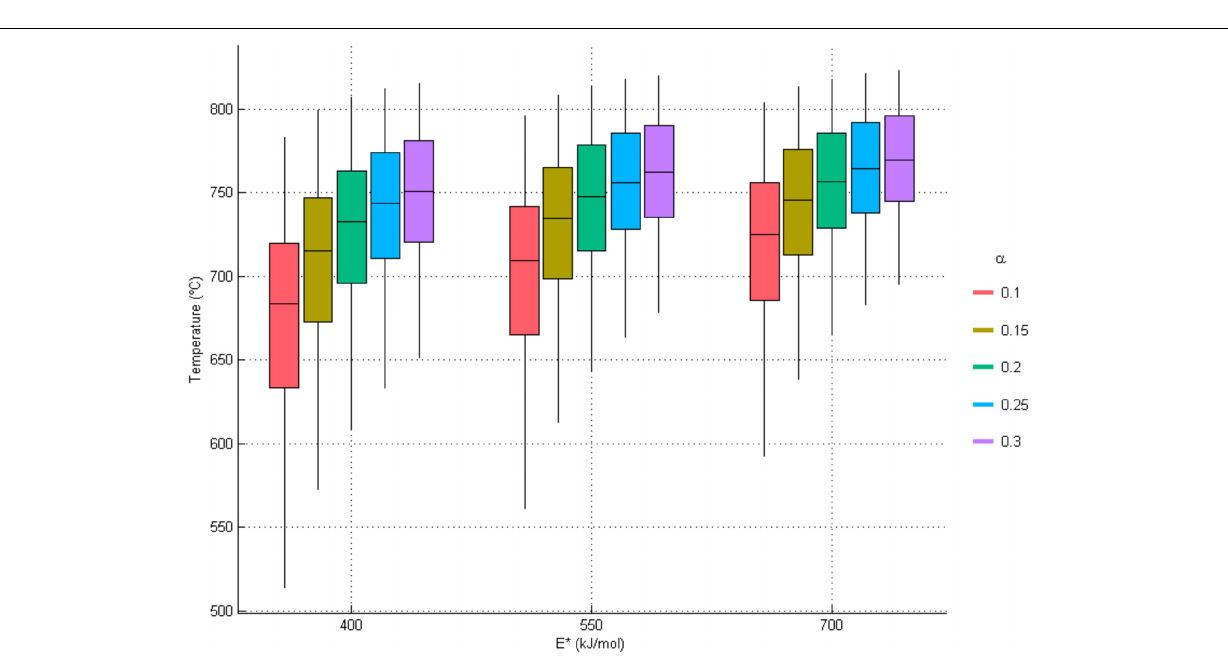
FIGURE 6 | Variation of temperatures using the ranges 400 ≤ E ∗ ≤ 700, 0 . 1 ≤ α ≤ 0 . 3, and 25 ≤ depth ≤ 100 km. Temperatures estimated are relatively low for this region, between ∼ 520 and ∼ 830 ◦ C. In order to tie coherently other thermal observations (xenoliths and geothermal gradient records) we chose the next values: α = 0 . 2, and E ∗ = 550